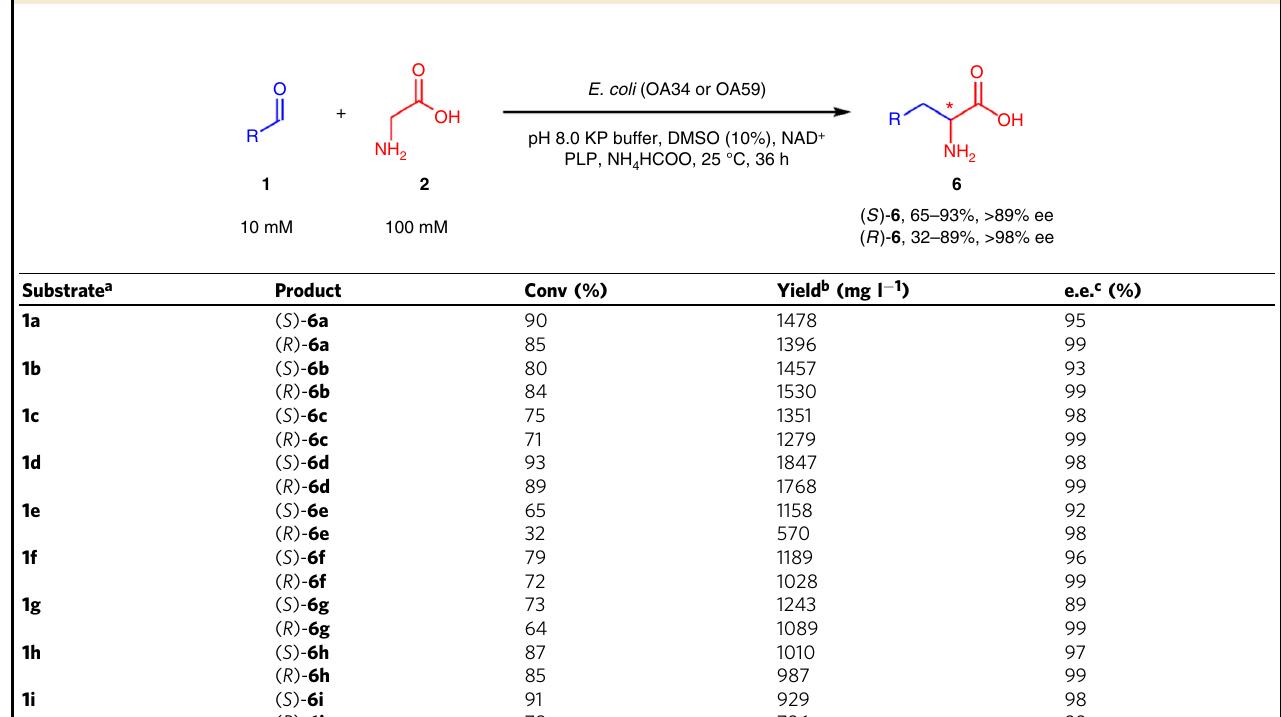
Table 2 Analytical biotransformation of glycine and aldehydes to α -amino acids by cascade biocatalysis